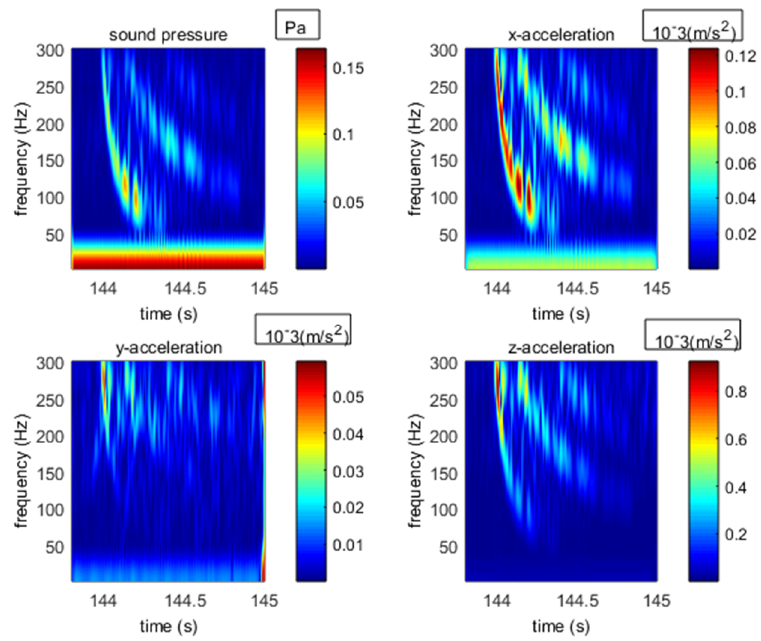
Figure 36. Figure 36. The time-frequency analysis for different channels. Figure 36. The time-frequency analysis for different channels. Figure 36. The time-frequency analysis for different channels.